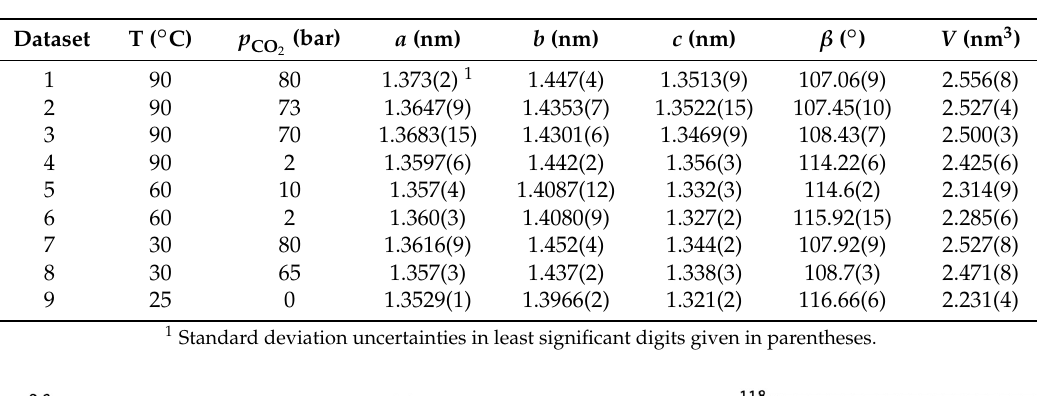
Table 1. Estimated unit cell parameters of 9 XRD datasets (sets 1–8 from USAXS/SAXS/WAXS measurements and set 9 from powder XRD data taken at room temperature and ambient pressure.).